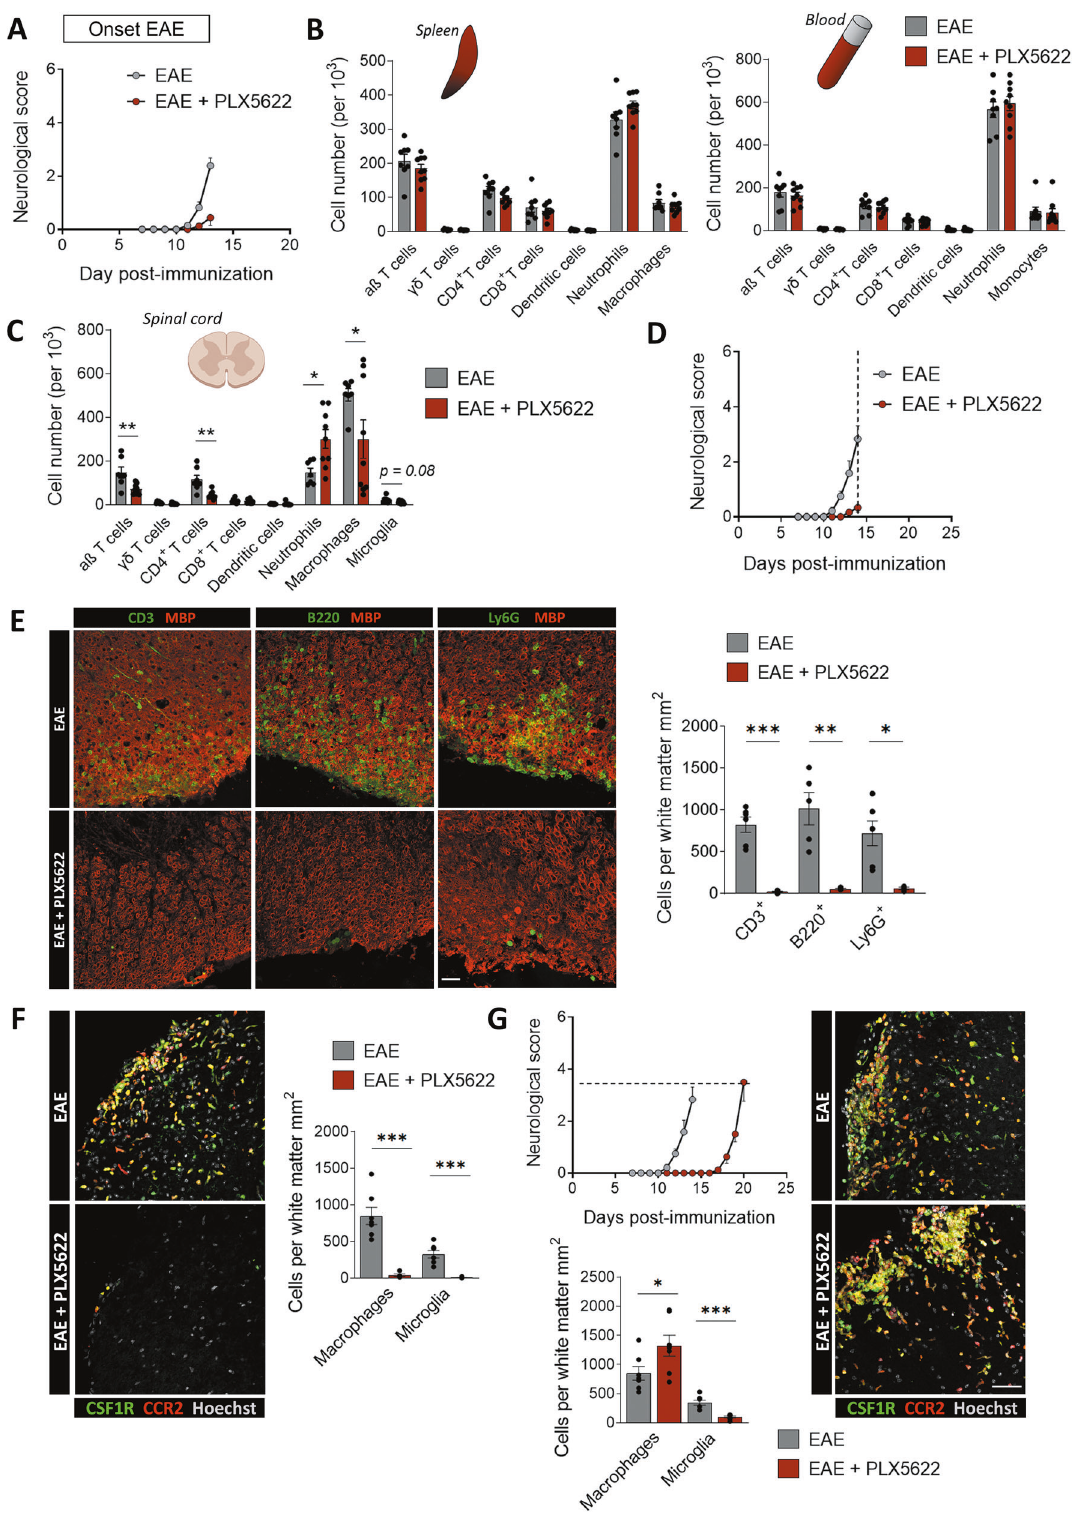
remyelinating mechanisms occurring in the chronic phase. On the other hand, microglia and meningeal macrophages are important to EAE development as their deletion delays immune cell activation responsible for the onset of the disease, by altering the antigen presentation in the